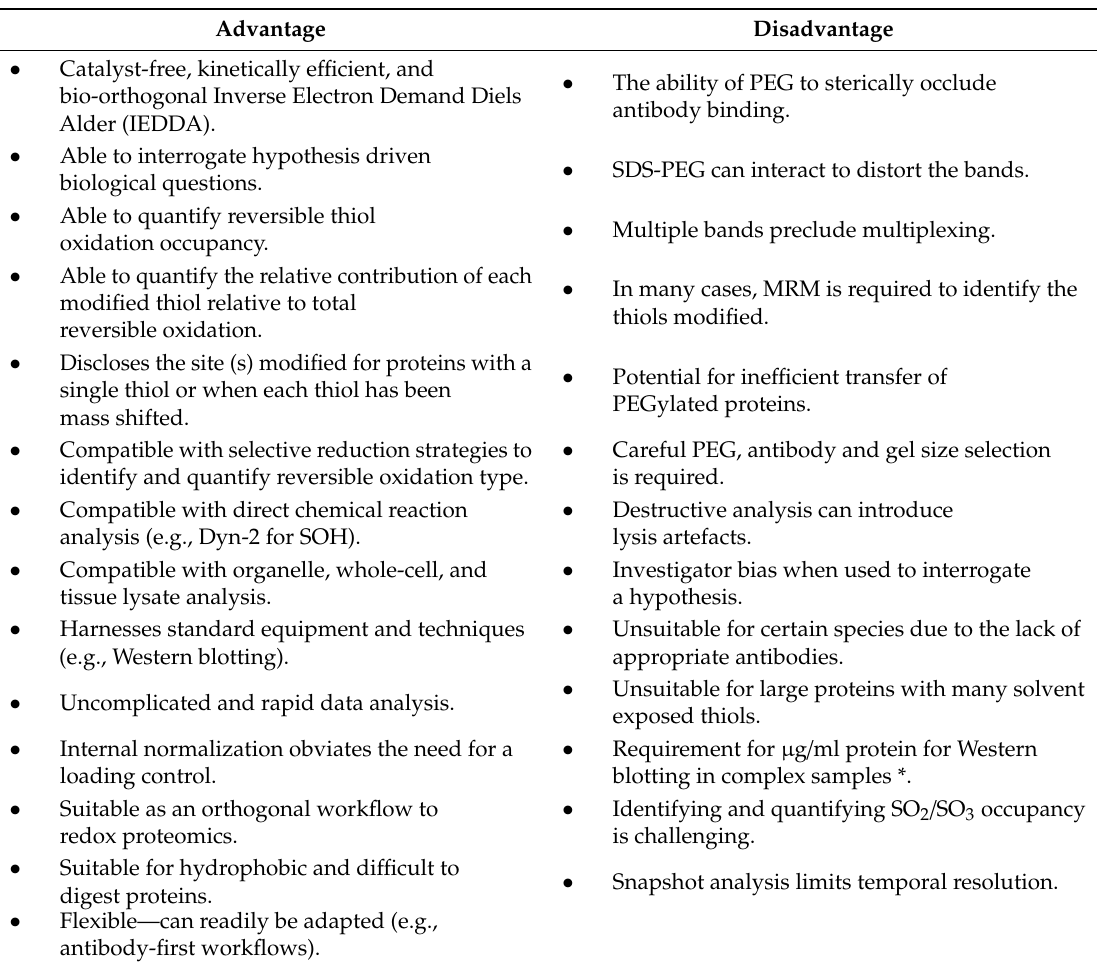
Table 2. Key advantages and disadvantages of Click PEGylation. Modified with permission from Cobley and colleagues